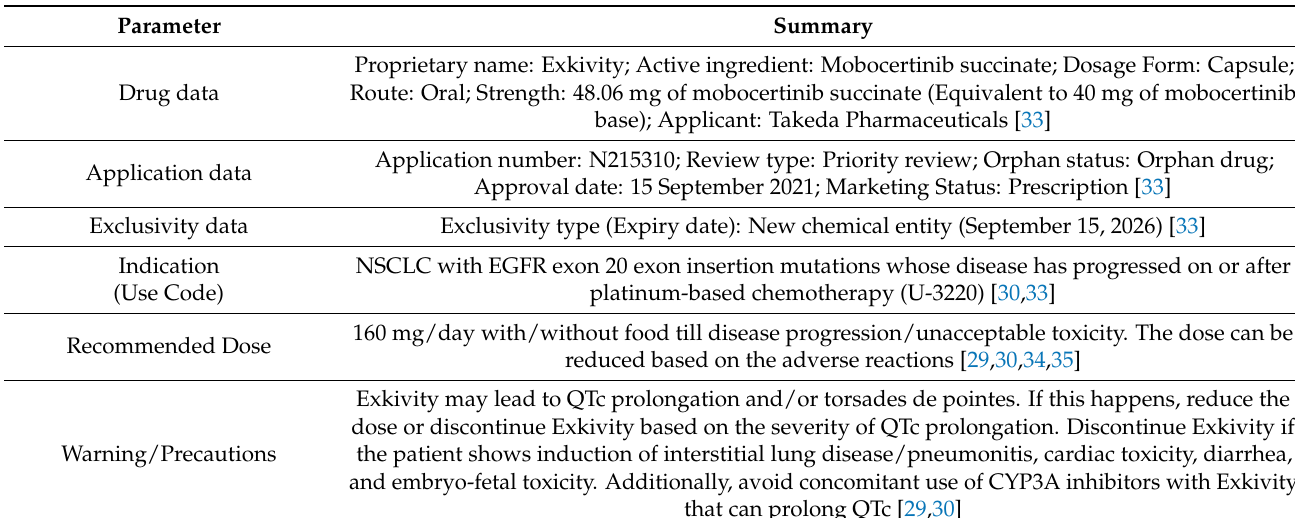
Table 1. R x data of mobocertinib.